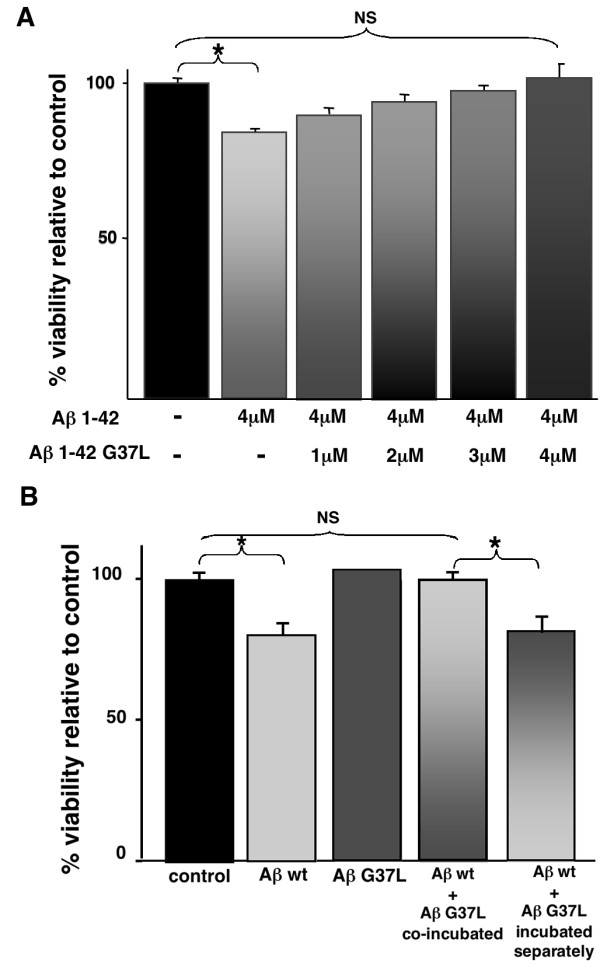
Toxicity of Aβ wild type and Aβ G37L peptides on Neuro 2a cells. Relative viability of Neuro 2a cells after treatment with Aβ wild type and Aβ G37L peptides for 24 hours, either singly or in various combinations. Viability was measured by the MTT assay and normalized to the vehicle-treated control cells. A. Neuro 2a cells were treated with 4 μM Aβ wild type that had been mixed with from 0-4 μM Aβ G37L for 20 min at RT before addition to the cells. The viability of each mixture was significantly different from that of Aβ wild type alone, and there was no significant difference in the viability of the vehicle control and an equimolar mixture of Aβ wild type and Aβ G37L (Student's t-test). Overall, Aβ G37L mitigated the toxicity of Aβ wild type in a linear dose dependent manner (R2 = 0.98). B. Neuro 2a cells were treated as described above with 4 μM Aβ wild type and/or 4 μM Aβ G37L. Note that the ability of Aβ G37L to inhibit Aβ wild type toxicity is lost when these peptides are oligomerized separately before addition to the Neuro 2a cell culture. (* P < 0.05, NS = not significant).